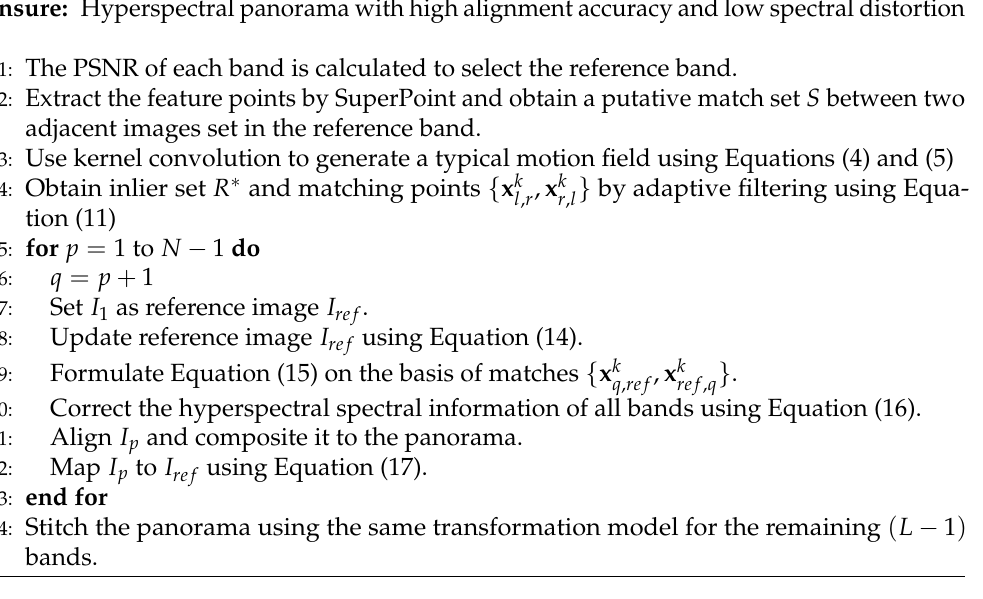
Algorithm 1 Hyperspectral panoramic image stitching using robust matching and adaptive bundle